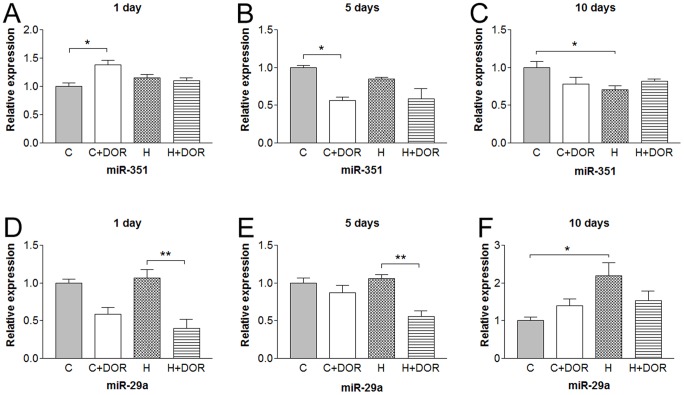
Relative miRNA expression levels of miR-351 and miR-29a in the kidney following either 1, 5, or 10 days of hypoxia as determined by quantitative RT-PCR.C, control; C+DOR, control+UFP-512; H, hypoxia; H+DOR, hypoxia+UFP-512. *p<0.05, **p<0.01.